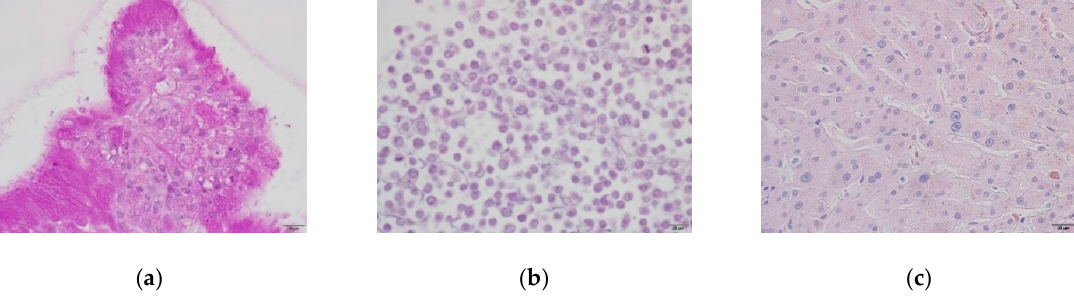
Figure 3. Glycogen accumulation in organoids and HepG2 cells. Polysaccharides or mucosubstances were stained positively with a magenta color. ( a ) DM day 12 organoids; ( b ) HepG2 cells; ( c ) Human liver tissue. Original magnification, ×400. Bar indicates 20 μ m.